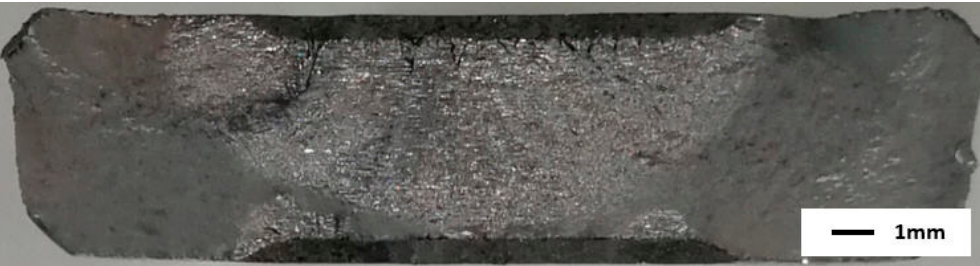
Figure 16. Failure surface associated with specimen AMC_F_1, failed at 38,677 cycles.